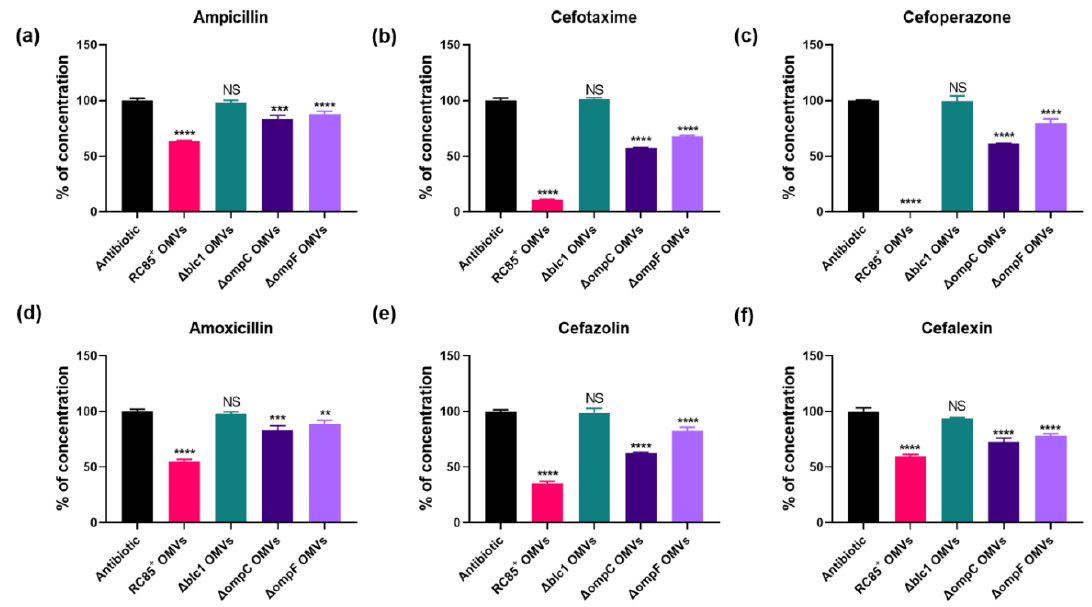
Figure 6. Evaluation of the concentration of β-lactam antibiotics incubated with 5 μg/mL of intact OMVs from RC85 + and isogenic mutant strains of RC85 + (Δblc1, ΔompC, and ΔompF). The initial concentrations and certain time points for measurement were as follows: ampicillin, 30 μg/mL, 5 h ( a ); cefotaxime, 1.25 μg/mL, 4 h ( b ); cefoperazone, 4 μg/mL, 3 h ( c ); amoxicillin, 12 μg/mL, 5 h ( d ); cefazolin, 8 μg/mL, 1 h ( e ); cefalexin, 16 μg/mL, 11 h ( f ). Respective antibiotics without OMVs were averaged and normalized as 100%, and the corresponding concentration of antibiotics with OMVs were calculated. The data are presented as means and SEMs of three independent experiments. The abbreviation ‘ns’ means not significant. ** p < 0.01, *** p < 0.001 and **** p < 0.0001.